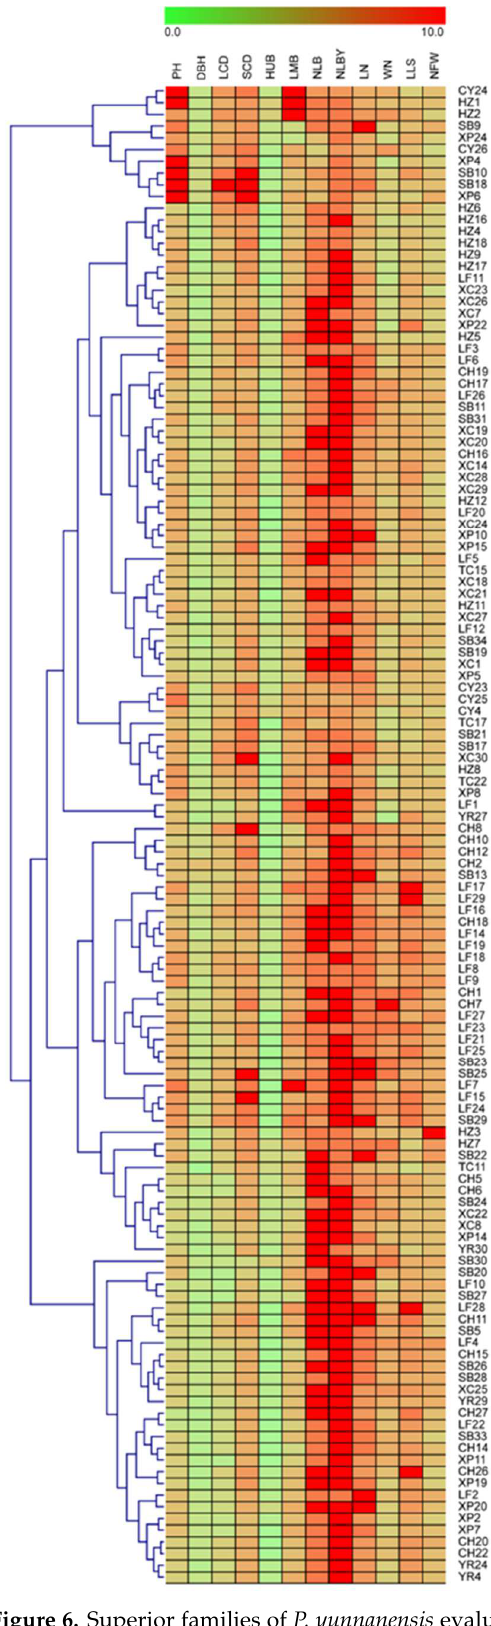
Figure 6. Superior families of P. yunnanensis evaluated by the heatmap. Population abbreviations and phenotypic trait abbreviations are shown in Table 1 and Figure 2, respectively.